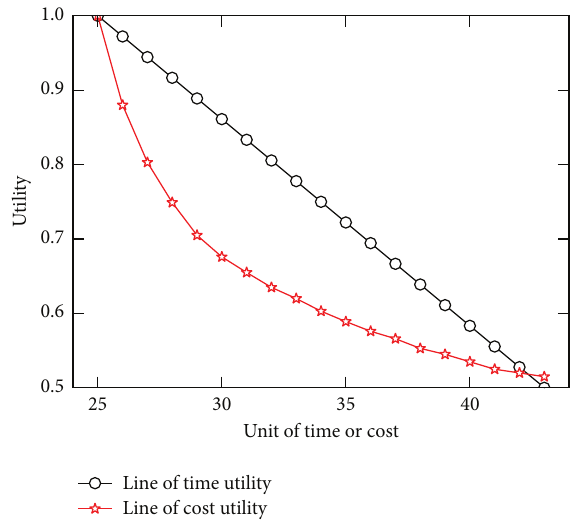
Figure 5: Time and cost utility lines for cost sensitive user